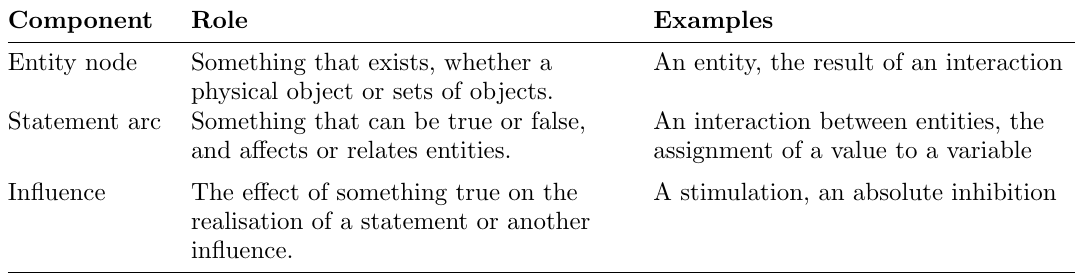
Table 1.1: Summary of Entity Relationship components and their